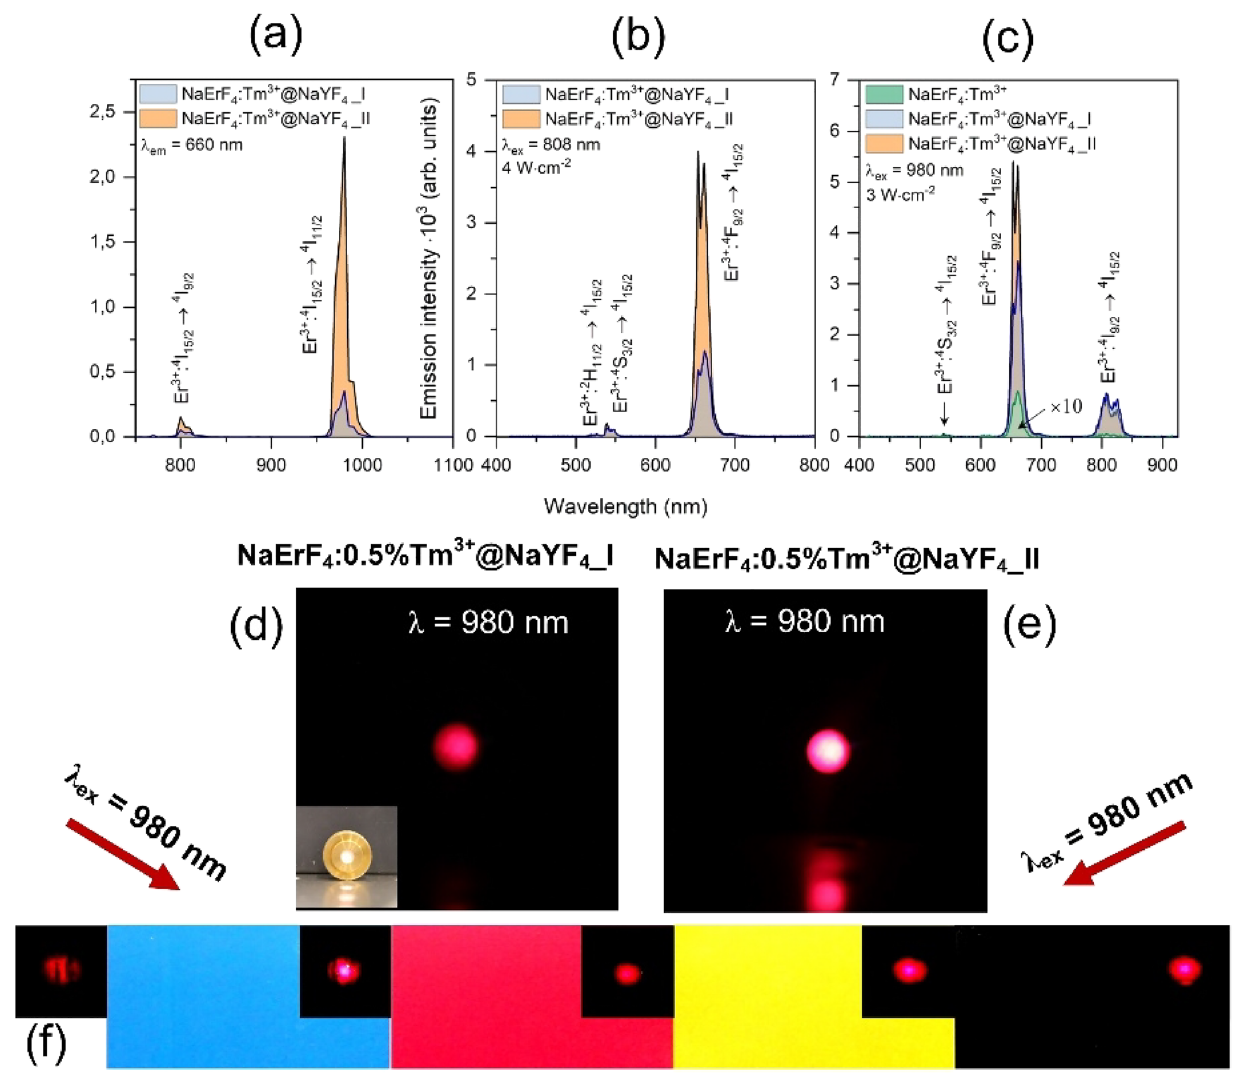
Figure 3. ( a ) Excitation spectra in the NIR range of the synthesized nanoparticles and their emission under ( b ) 808 nm and ( c ) 980 nm excitations; ( d , e ) emission of nanoparticles in the form of powders, ( f ) emission from UCNPs embed into transparent varnishes used to cover selected ink